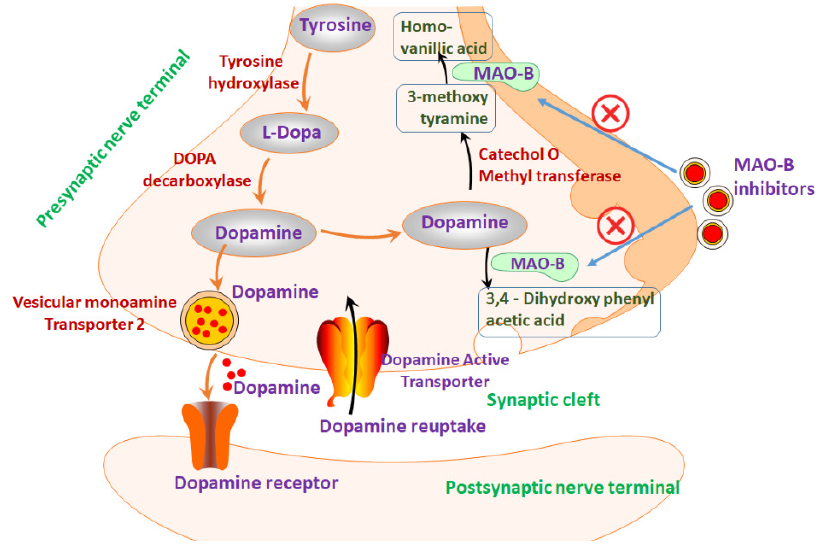
Figure 1. Mechanism of MAO-B inhibitors in